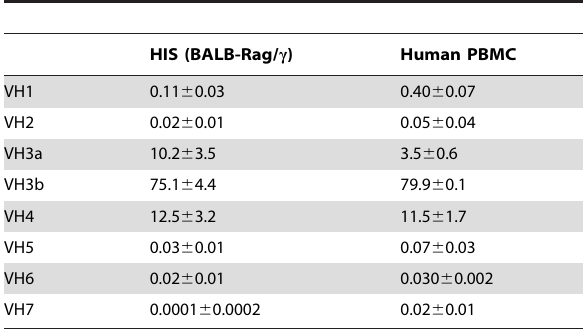
Table 1. Average V H family usage for IgM in HIS (BALB-Rag/ c ) mice and control human PBMC.